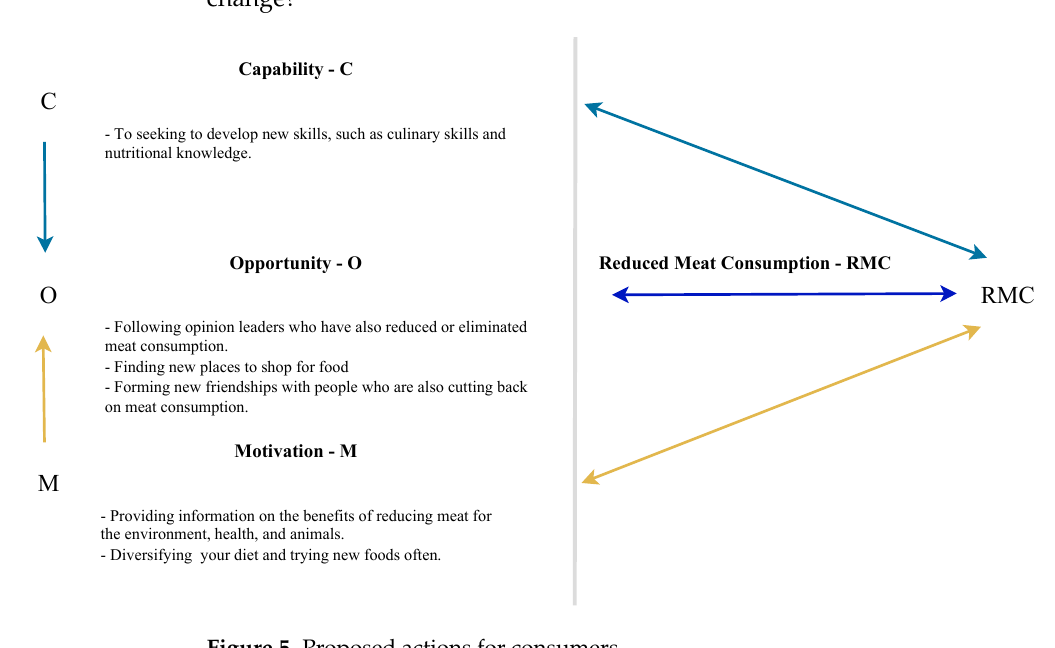
12 of 17 Figure 4. Proposed actions by external agents.